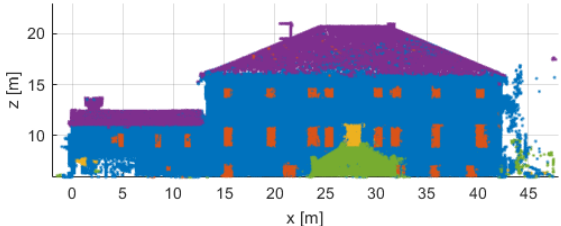
Figure 5. Predicted semantic segmentation of Villa Roberti Bru- gine: best view